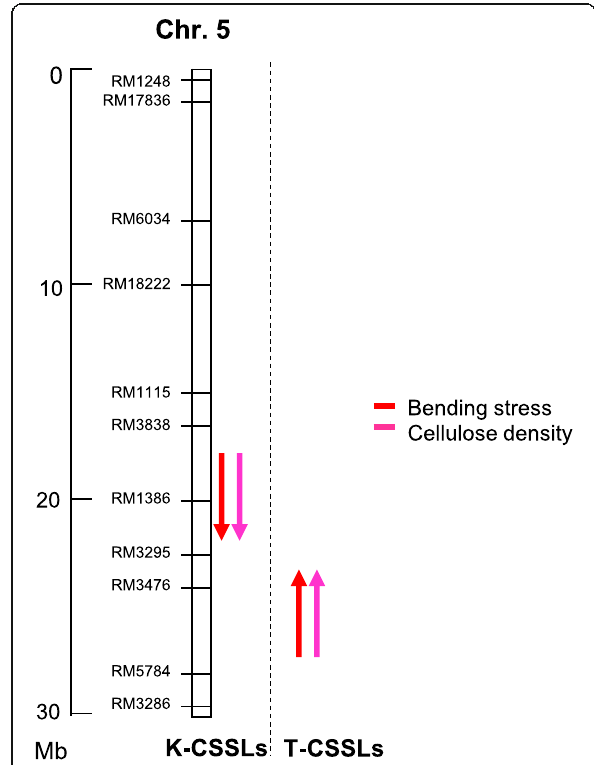
Fig. 7 Substitution mapping of QTLs by comparing overlapped segments among lines of K-CSSLs and T-CSSLs for BS and cellulose density on chromosome 5 in